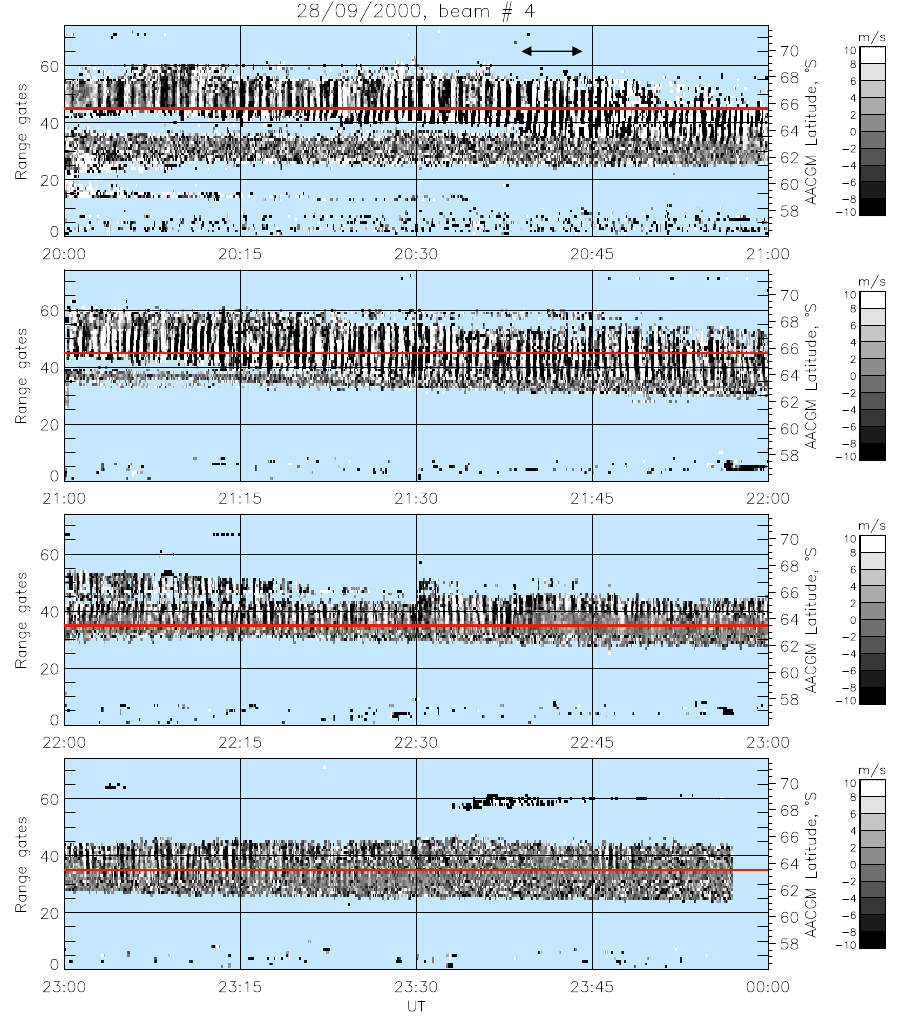
Fig. 4. Consecutive one-hour intervals of Doppler data over 20:00–24:00 UT shown in the same format as in Fig. 2. The red horizontal line corresponds to gates #45 and 35 used for further spectral analysis (see Figs. 6, 7). The black horizontal arrow in the top panel shows a time interval with FLR features analysed in detail in Fig.